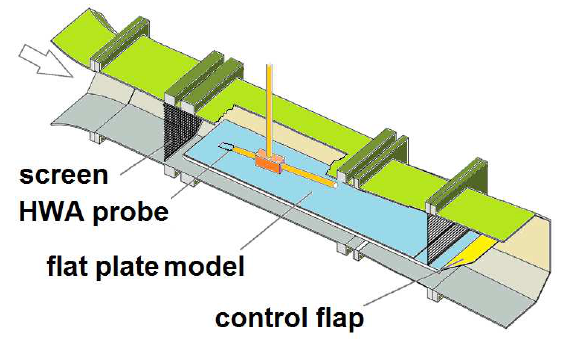
Fig. 1 . Experimental setup - flat plate in the windtunnel test section The flow deceleration starts at the level of the leading edge of the flat plate ( x = 0) where the flow velocity is set to U e = 10 m/s. Cases with adverse pressure gradient are provided by plane diffuser expanding part putted into test section. The diffuser channel was created in the test section for make the adverse pressure gradient in main flow belong flat plate. Length of this diffuser section is 1.4 m and opening angle was 5°. It was checked carefully that there was no flow separation on the deflected